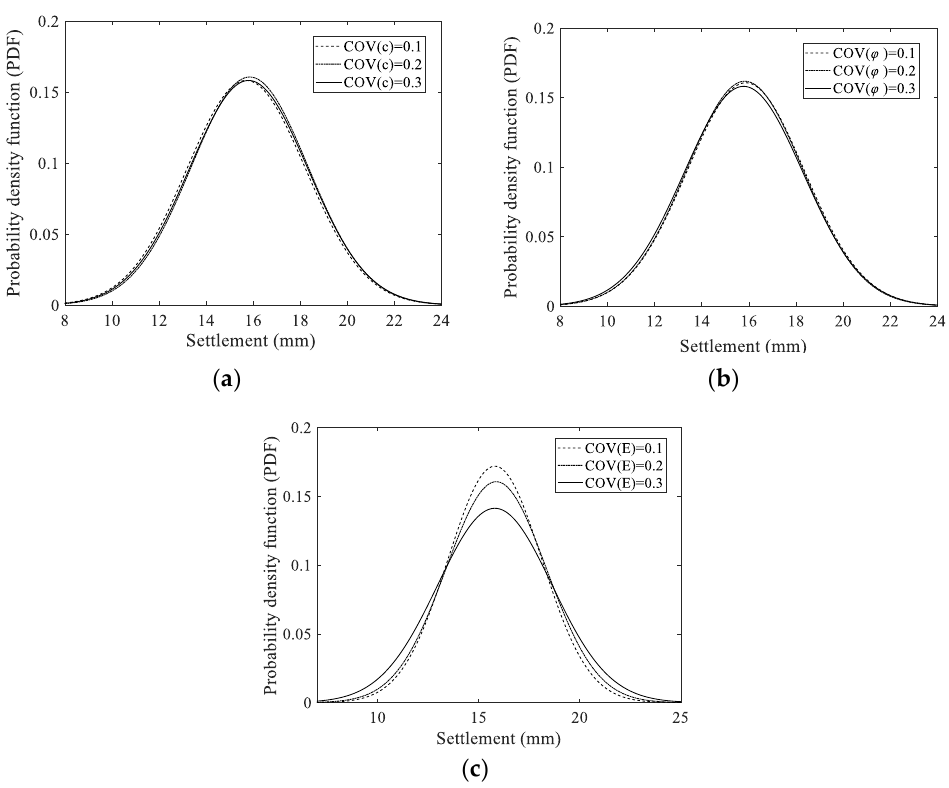
Figure 8. Effect of the soil COVs on settlement. ( a ) COV( c ); ( b ) COV( φ ); ( c ) COV( E ). Figure 8. E ff ect of the soil COVs on settlement. ( a ) COV( c ); ( b ) COV( ϕ ); ( c ) COV( E